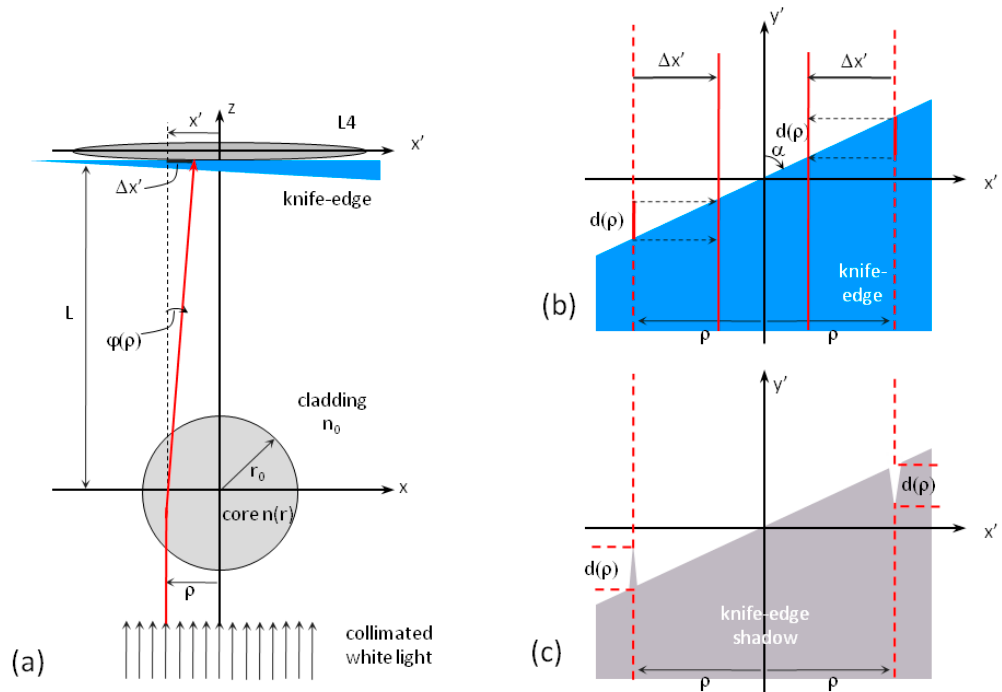
Figure 2. ( a ) Simplified schematic of collimated-ray deflection ϕ ( ρ ) through the core of an optical preform, ( b ) deflection visualization by the use of a spatial filter (knife-edge) placed at an angle α between the filter edge and the y’ -axis, and ( c ) geometric shadow modifications d( ρ ) as a result of ray deflections. L is the distance between the preform core center and the filter.